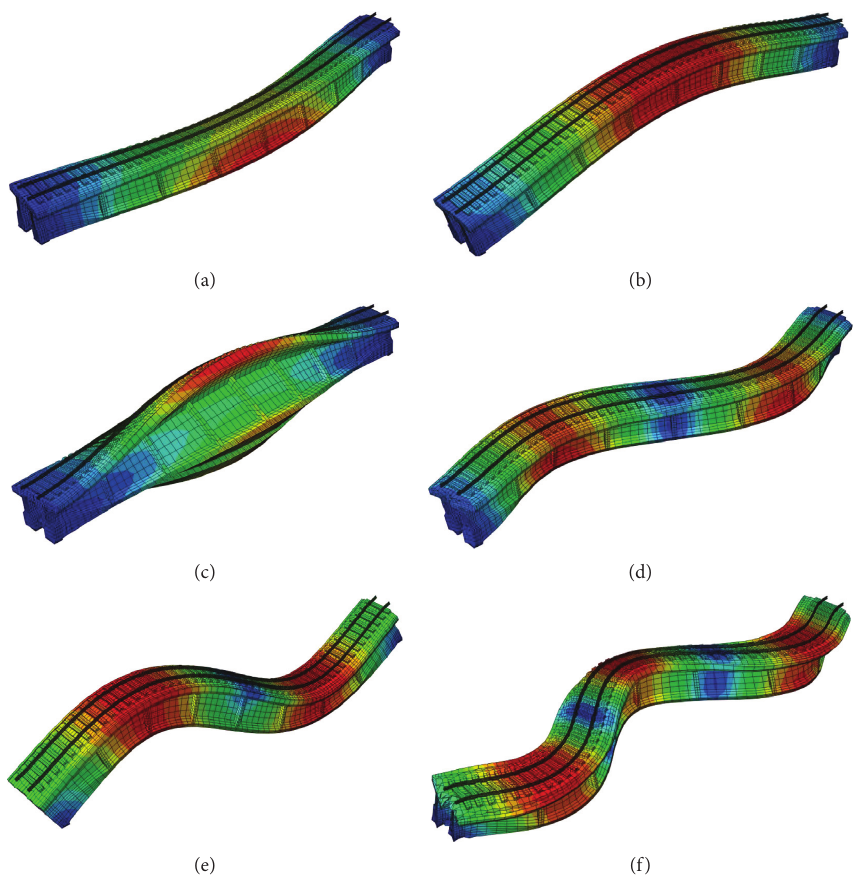
� 2.9Hz. (b) f � 5.62Hz. (c) f 1 2